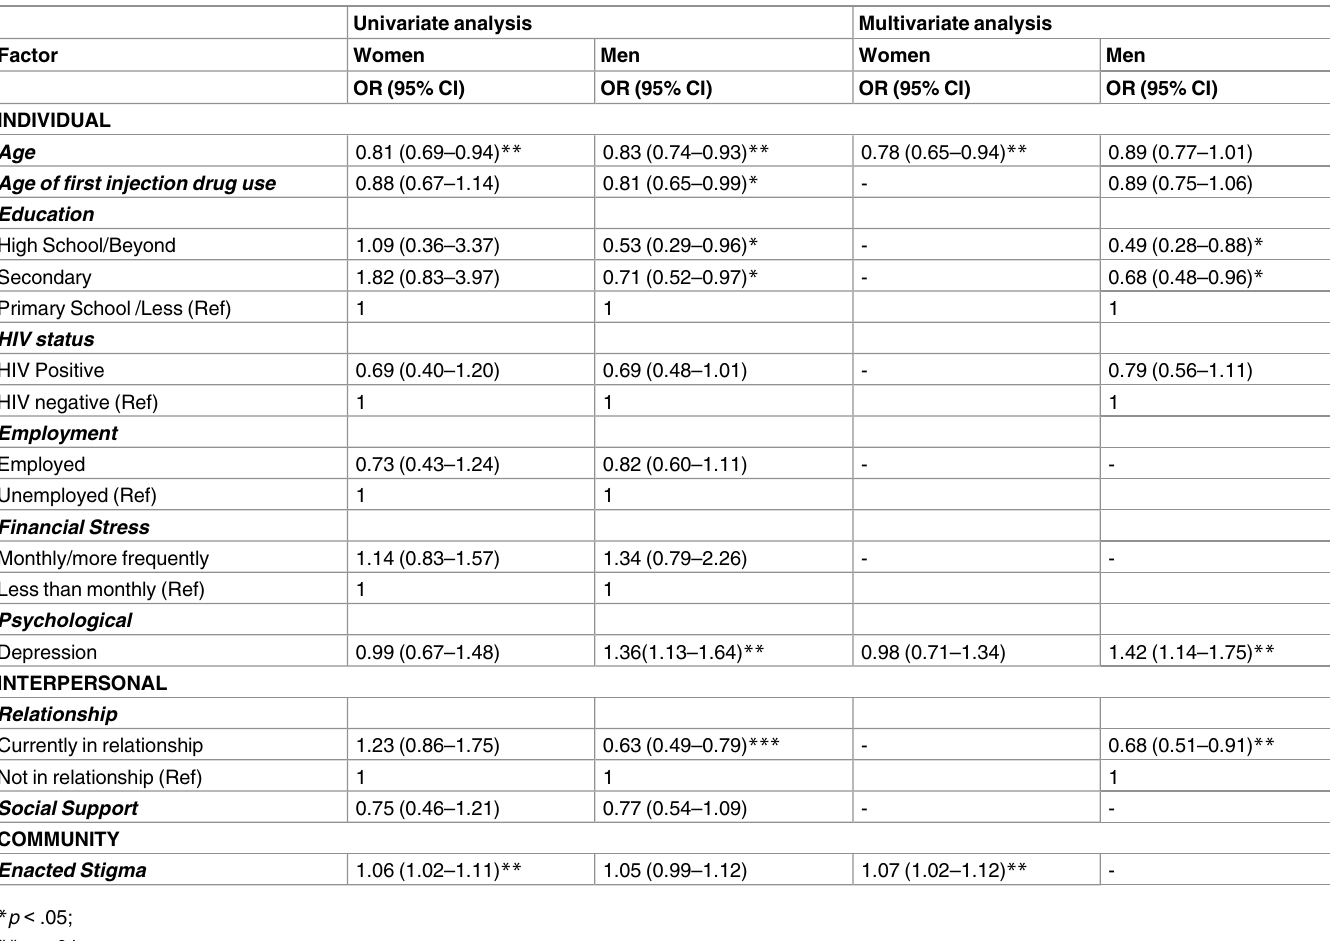
Table 4. Factors associated with recent needle sharing in men and women who injected drugs in seven cities in India (N =